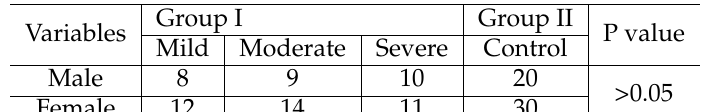
Table 1. Characteristics of subjects